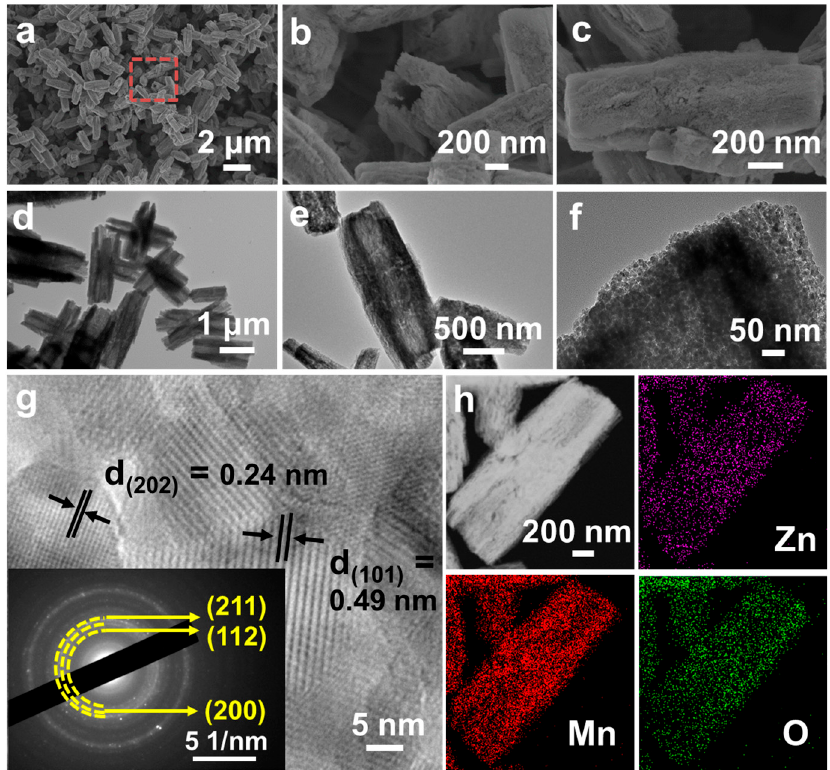
Figure 2. ( a – c ) FESEM images, ( d , e ) TEM images, ( f , g ) HRTEM images, SAED pattern (the inset in panel G), and ( h ) scanning TEM and corresponding EDS elemental (Zn, Mn, and O) mapping images of ZMO HMRs.